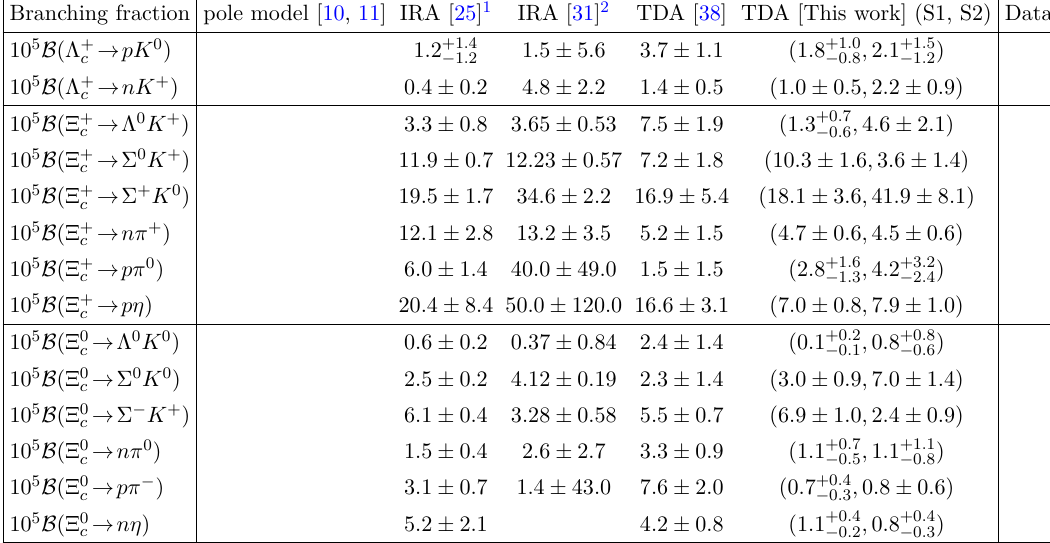
Table 7 . Doubly Cabibbo-suppressed (DCS) branching